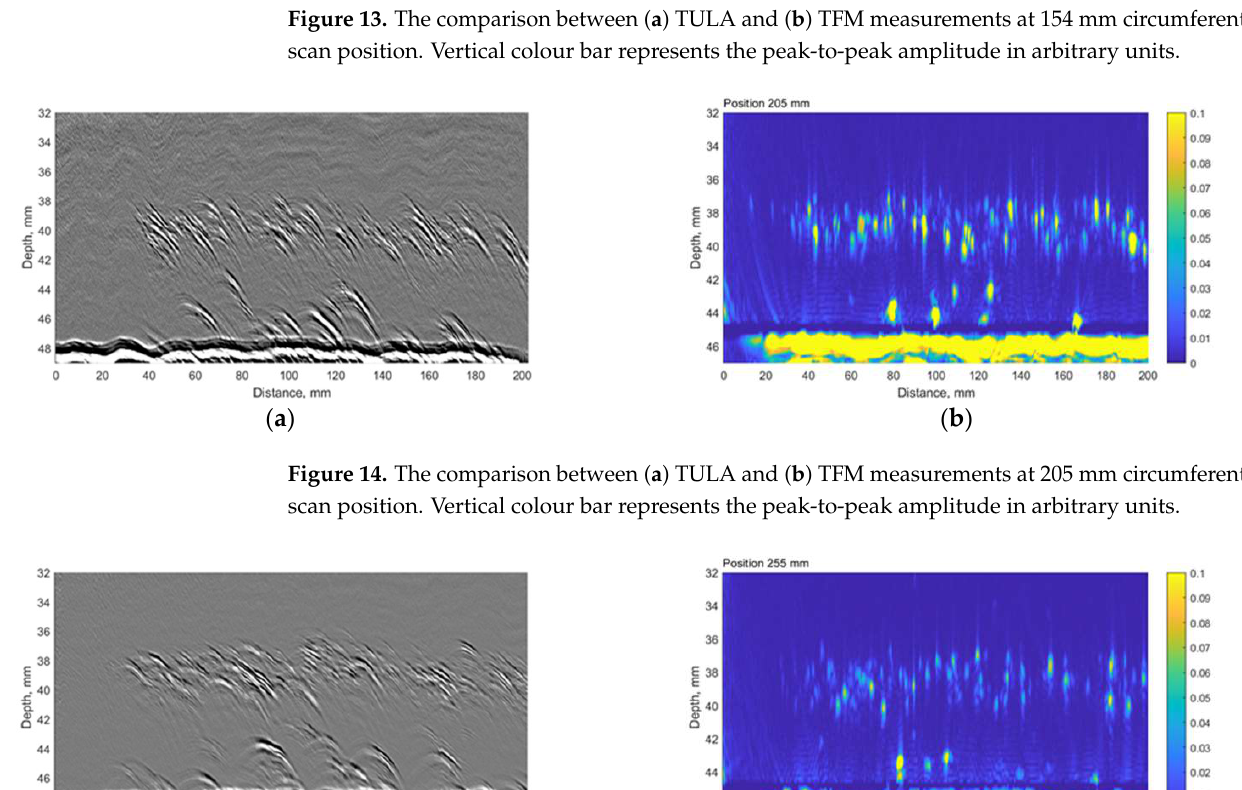
( b ) Figure 16. The comparison between ( a ) TULA and ( b ) TFM measurements at 306 mm circumferen- tial scan position. Vertical colour bar represents the peak-to-peak amplitude in arbitrary units. ( a ) ( b ) Figure 17. The comparison between ( a ) TULA and ( b ) TFM measurements at 404 mm circumferen- tial scan position. Vertical colour bar represents the peak-to-peak amplitude in arbitrary units. A good correlation can be observed between results obtained using the TFM and TULA method. Of course, there are some differences because it is impossible to scan ex- actly along the same line, especially considering the relatively small dimensions of the defect. The essentially higher resolution of TFM images can be noticed and it can be stated that the TULA technique, in general, enables the detection of HIC damage and is faster and simpler compared to the application of TFM with scanning. It is necessary to notice also that the frequency of TULA transducers (10MHz) is slightly higher that the frequency of the phased array (7.5 MHz) used by the TFM technique. 5. Metallographical Examination of a Heat Exchanger Shell Sample To prove the existence of HIC damage, a metallographic analysis must be performed. In this section, we continue our investigation of two of the most promising techniques, TFM and TULA, on sample no. 5, which is characterised by a metallographic analysis. To